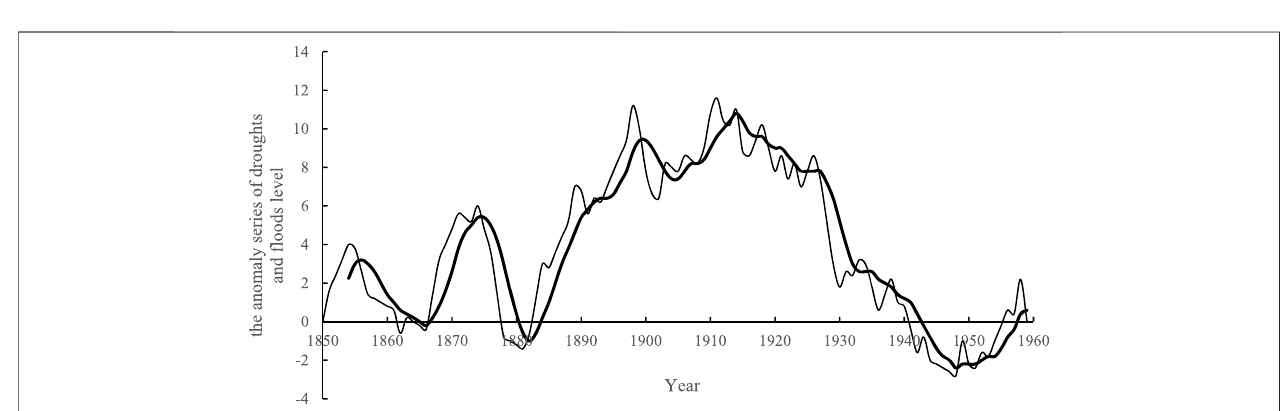
Frontiers in Earth Science |